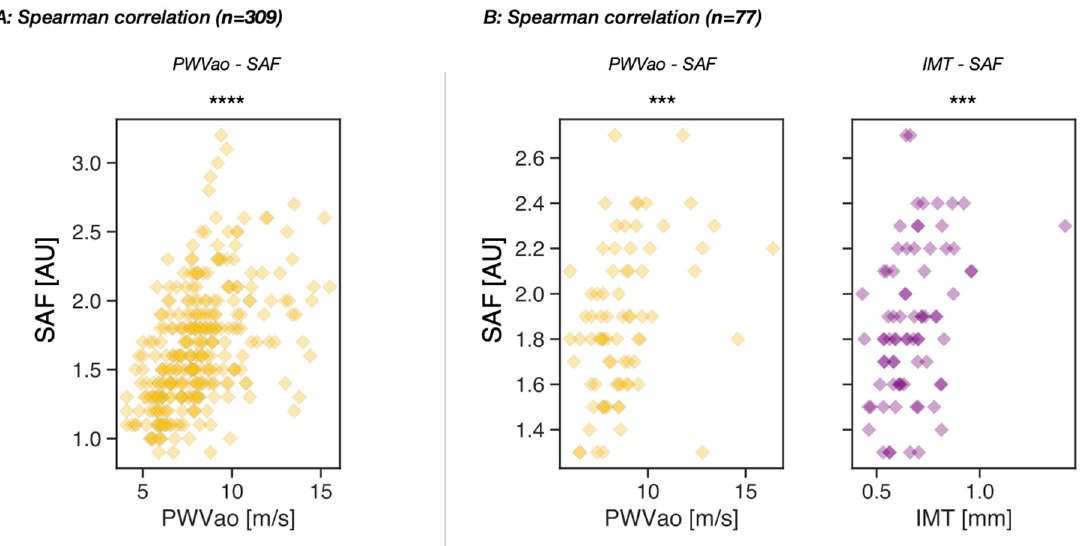
Figure 3. Interrelationship analysis between skin SAF values and PWVao or IMT. ( A ) Spearman’s correlation between PWVao and SAF values (yellow) in cohort ( n = 309); ( B ) spearman’s correlation between PWVao (yellow) or IMT (purple) with SAF values in cohort ( n = 77); Significances are given as ***: 1.00 × 10 − 4 < p ≤ 1.00 × 10 − 3 ; and ****: p ≤ 1.00 × 10 − 4 .